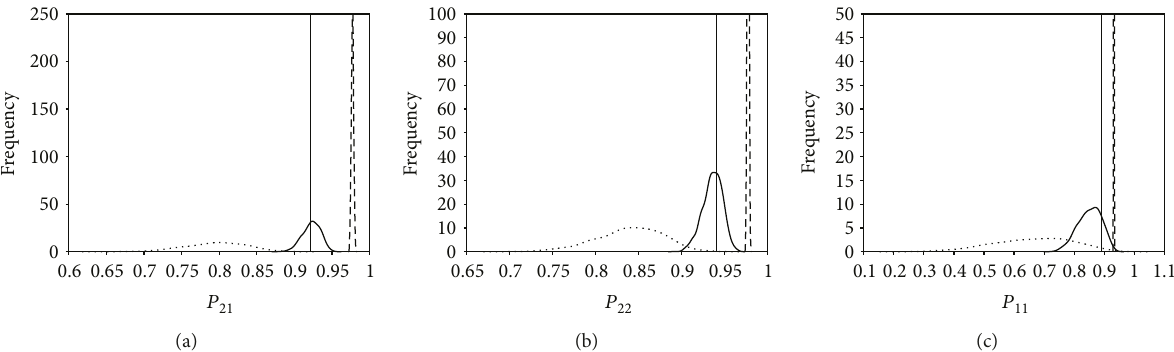
(a), E (b), and E (c). True parameter value (vertical line), basic probability (using only 21 22 11